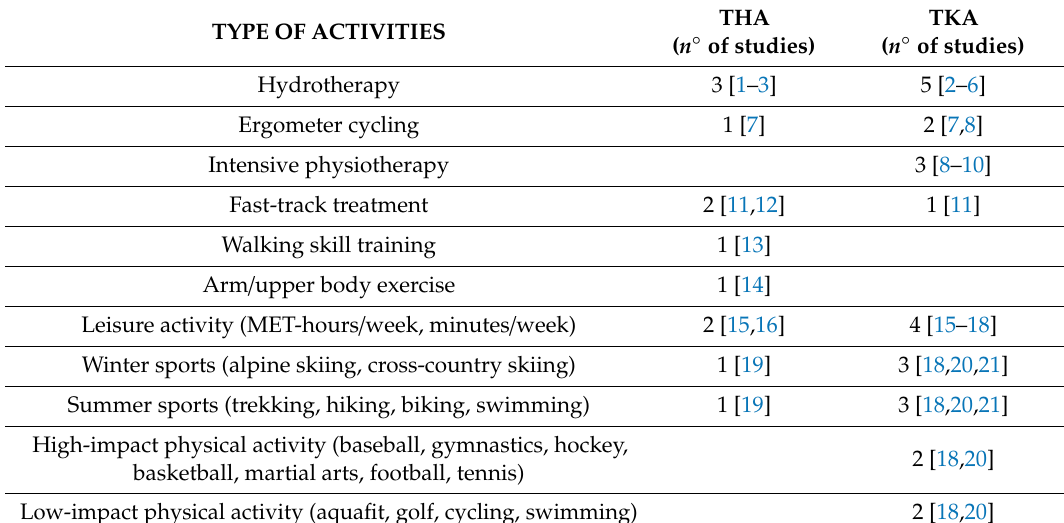
Table 2. Types of activity and number of studies in which they were